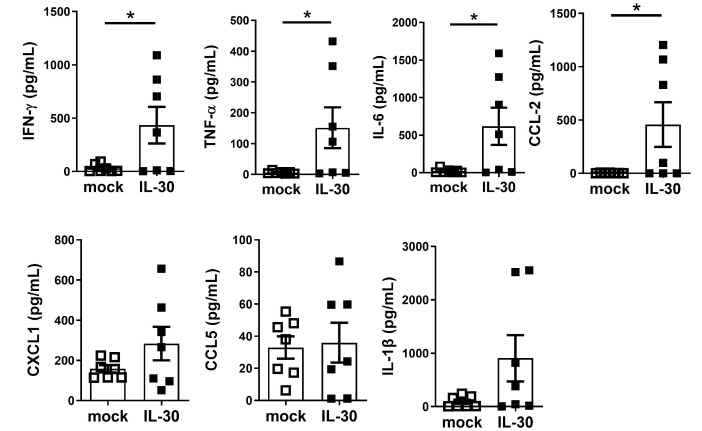
Figure 6. Administration of AAV-mIL-30 induced an increase in the levels of various cytokines and chemokines. Mice were injected with AAV-mIL-30 or AAV-mock at 3 weeks after the